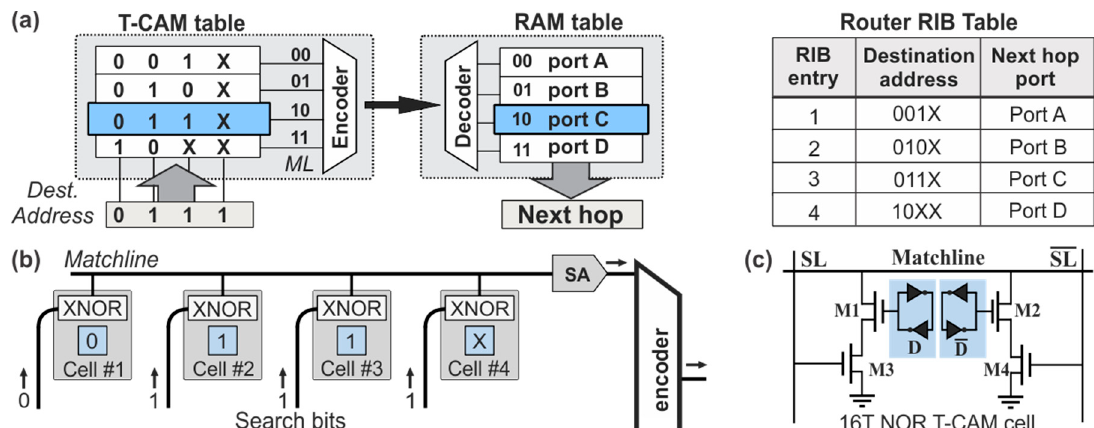
Figure 1. ( a ) Electronic AL memory architecture comprising a T-CAM table interconnected to a RAM table and the respective router Routing Information Base (RIB) list; ( b ) Logical circuit of an electronic Matchline architecture; and ( c ) the standard electronic 16T Not OR (NOR) T-CAM cell architecture.